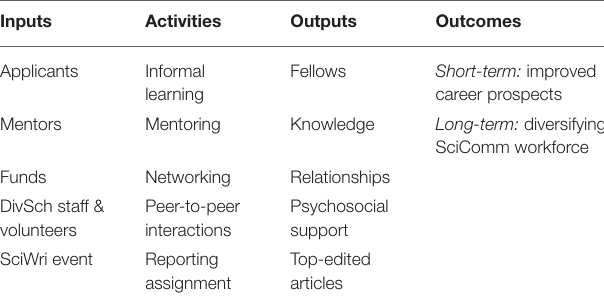
TABLE 1 | Simplified logic model of the SciCommDiversity fellowship that the DiverseScholar (DivSch) non-profit administered allowing fellows to attend the ScienceWriters (SciWri)